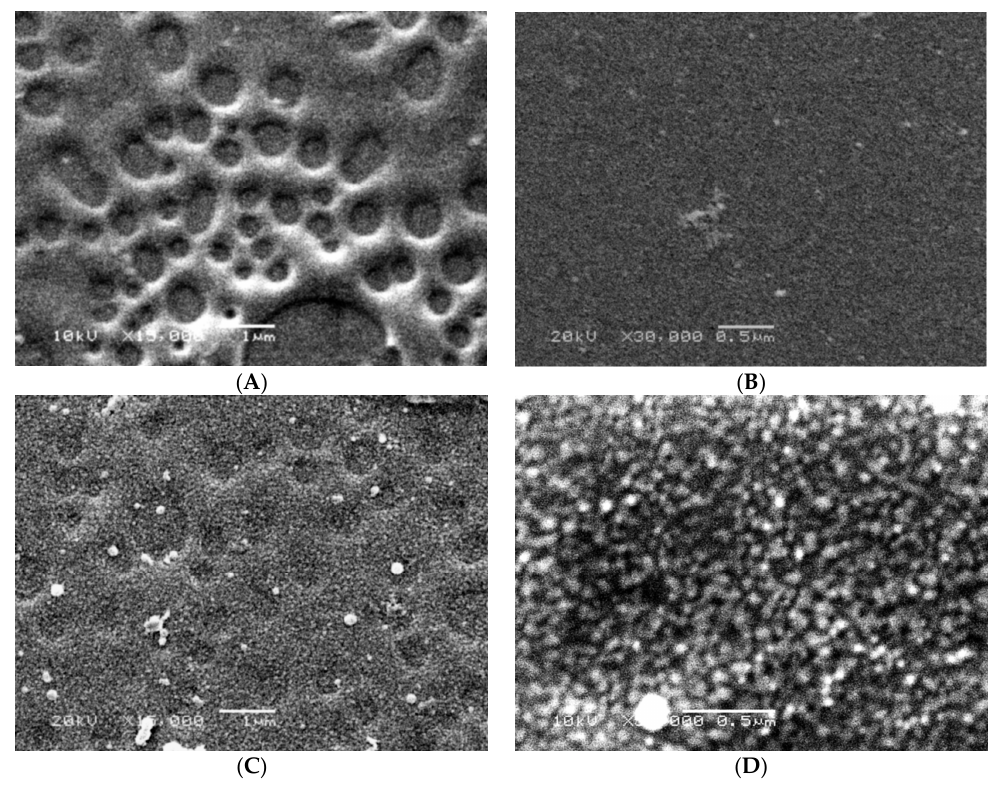
Figure 10. The scanning electron microscope (SEM) of the laminated poly(ethersulfone) (PES) layer on silicon dioxide slides using 15,000× and 30,000× magnification: ( A , B ) the blank laminated PES layer at the two magnifications; and ( C , D ) the modified laminated PES layer at the two magnifications using modification condition: 15 mM 2-AP, pH 5.5 (0.1 M sodium acetate buffer), and 0.5 U·mL − 1 enzyme (laccase) modified for 60 min at 25 °C.